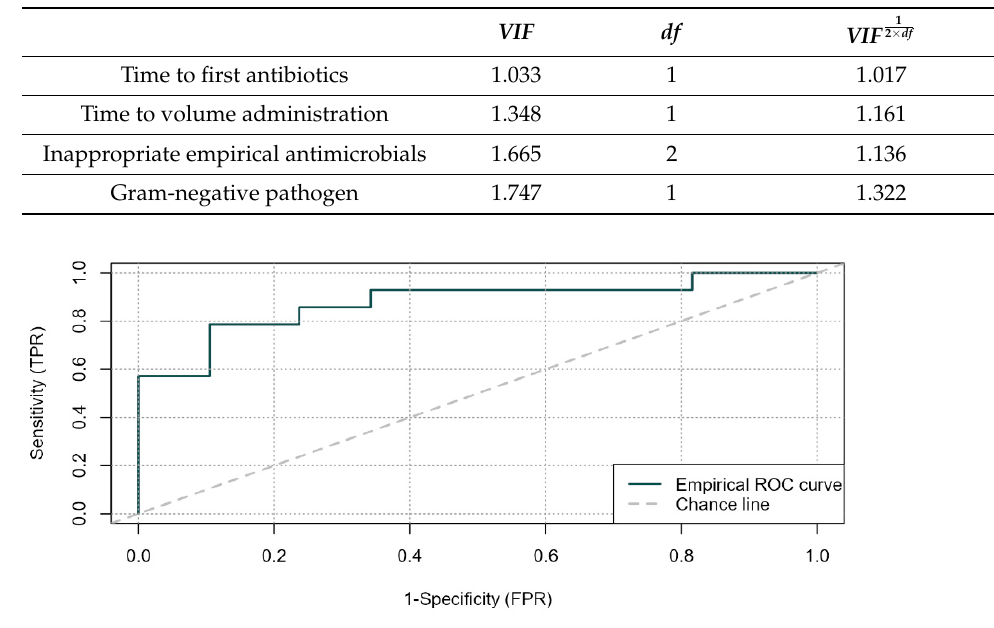
1 2 × df for each term of the